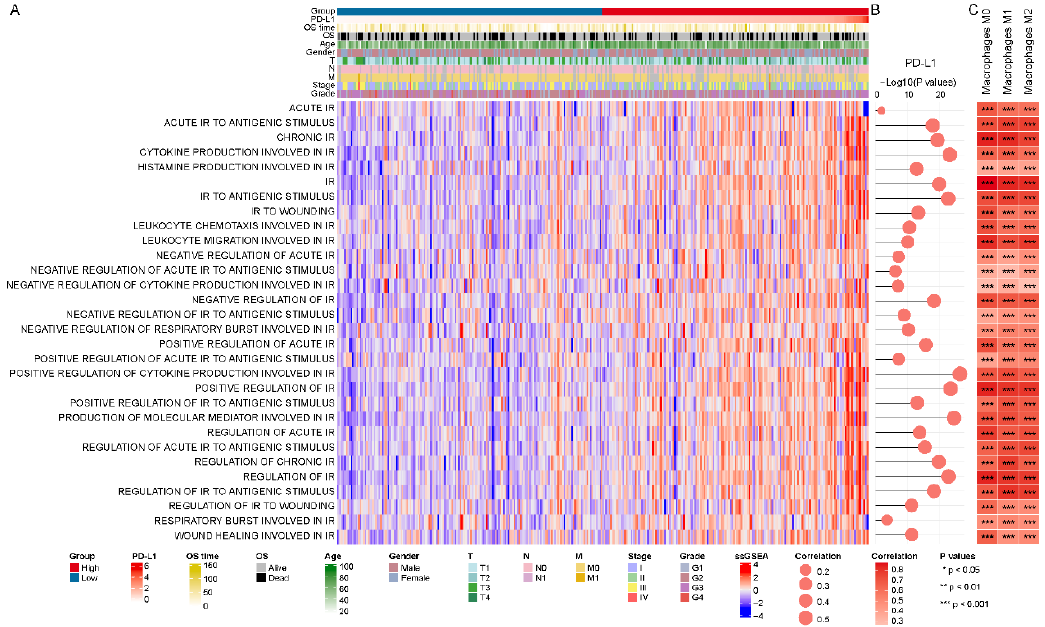
Figure 5. PD-L1-related inflammatory response activity in the TCGA LIHC cohort. ( A ) The en- richment score of inflammatory response (IR) biological processes using GSVA. ( B , C ) The correlation of activation of inflammatory response (IR) with the expression level of PD-L1 and infiltration level of macrophages, respectively.